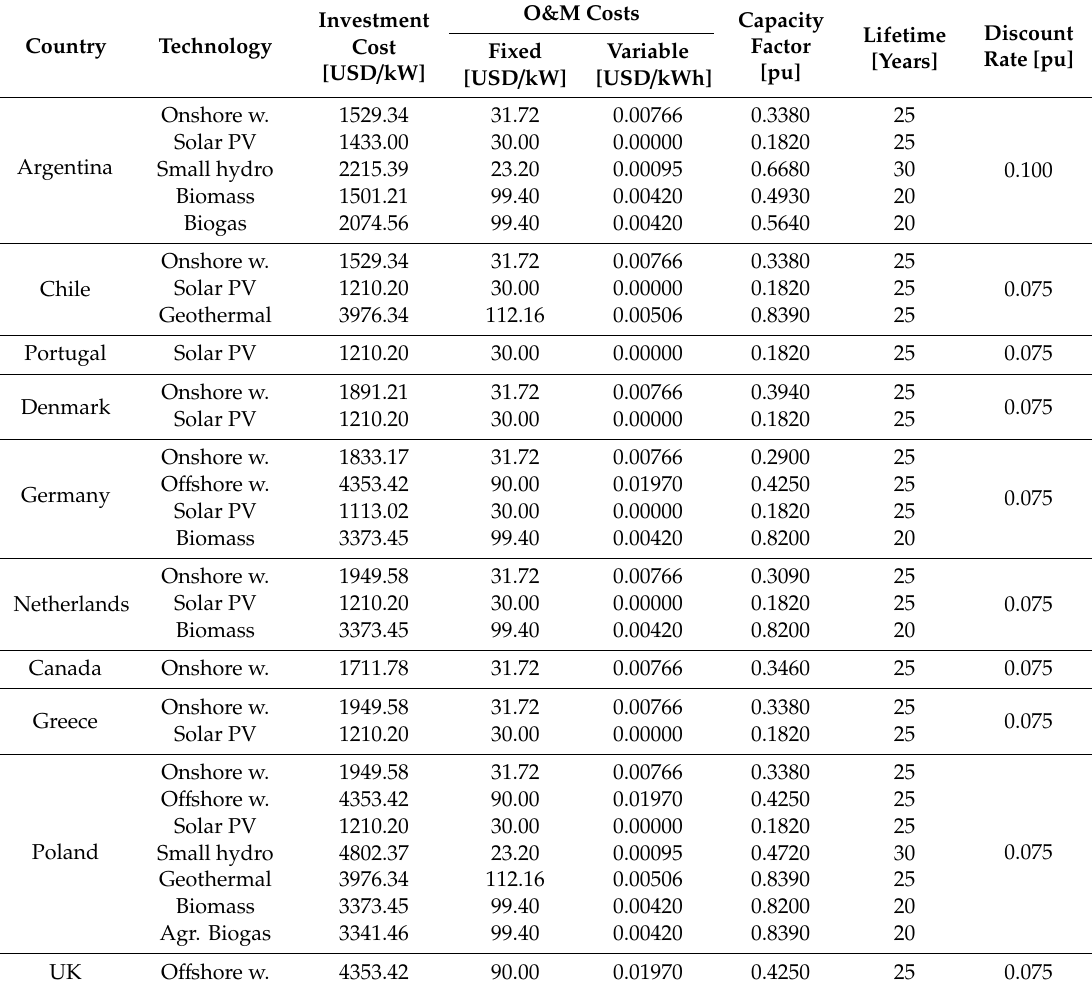
Table 2. Levelised cost of energy (LCOE) input data for the RES technologies of the analysed auctions. Source: self-elaboration based on [30,31].